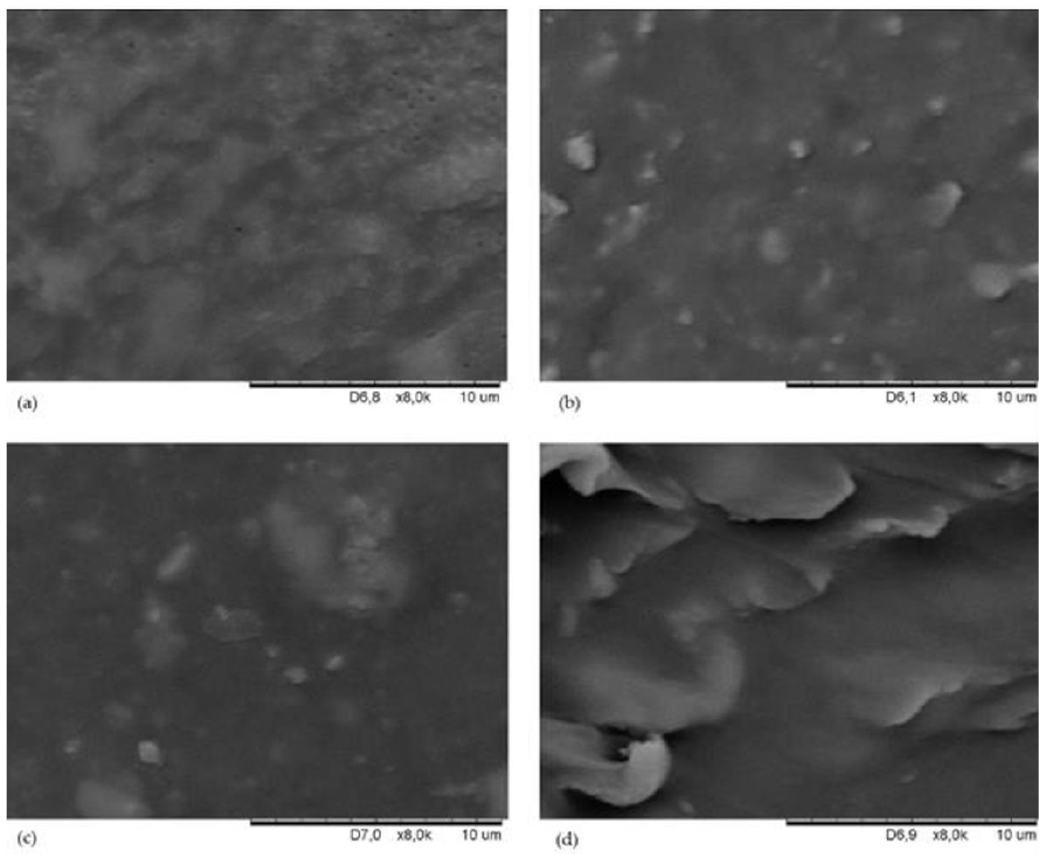
Figure 2. SEM images of the surface of CR/BR/Zn ( a ); CR/BR/Zn/sillitin ( b ); CR/BR/Zn/chalcedonite ( c ); and CR/BR/Zn/aerosil ( d